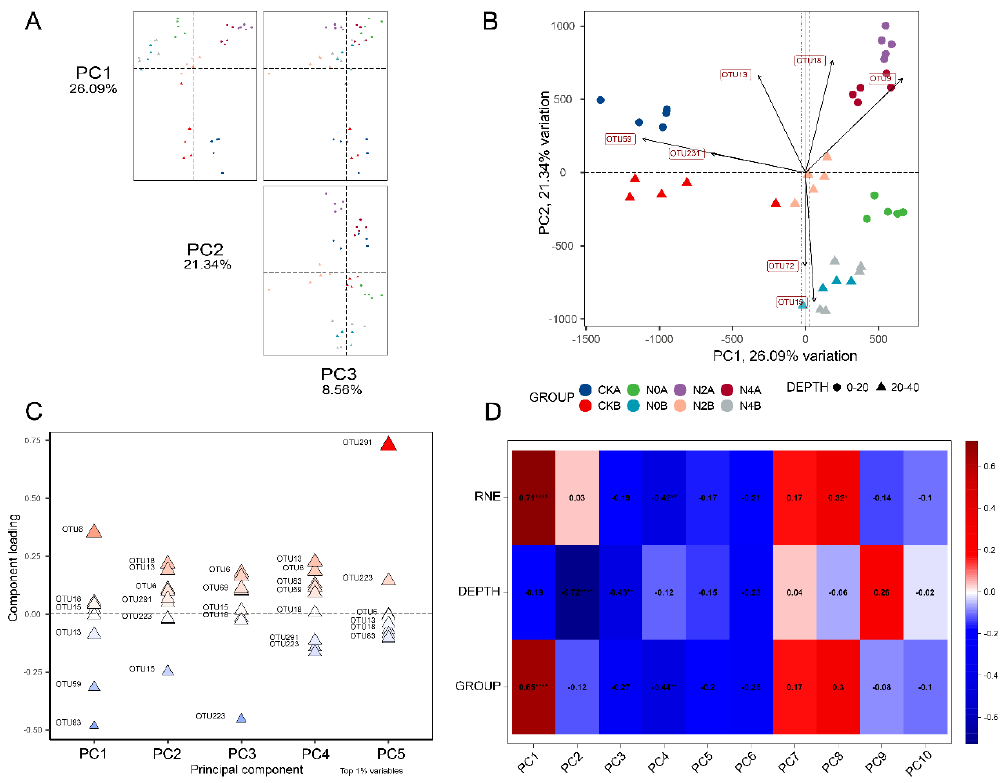
Figure 4. Bacterial PCA analysis. ( A ) Score plot. The first three PCs were shown. The percentages represent the variance explanation scale. The points represent the observation sample. Treatments are shown in different colors. ( B ) Biplot. Dots represent observation samples. Circles are 0 – 20 cm soil. Triangles are 20 – 40 cm soil. RNE treatments are shown in different colors. The line segments represent the main differences between OTUs. The magnitude of the angle between the line segments and the points represents the positive, negative and level correlation and the level. ( C ) Loadings plot. The OTUs with a significant relationship with PC1 – 5 are shown. Redder colors mean higher correlation. ( D ) Eigencor plot. Correlations between PC1 – 10 and RNE, soil depth and sample grouping were demonstrated. Red represents positive correlations and blue represents negative correlations. Darker colors represent higher correlations, * represents the significance to 1 × 10 − 2 , ** represents significance to 1 × 10 − 3 and **** represents 1 × 10 − 5 .